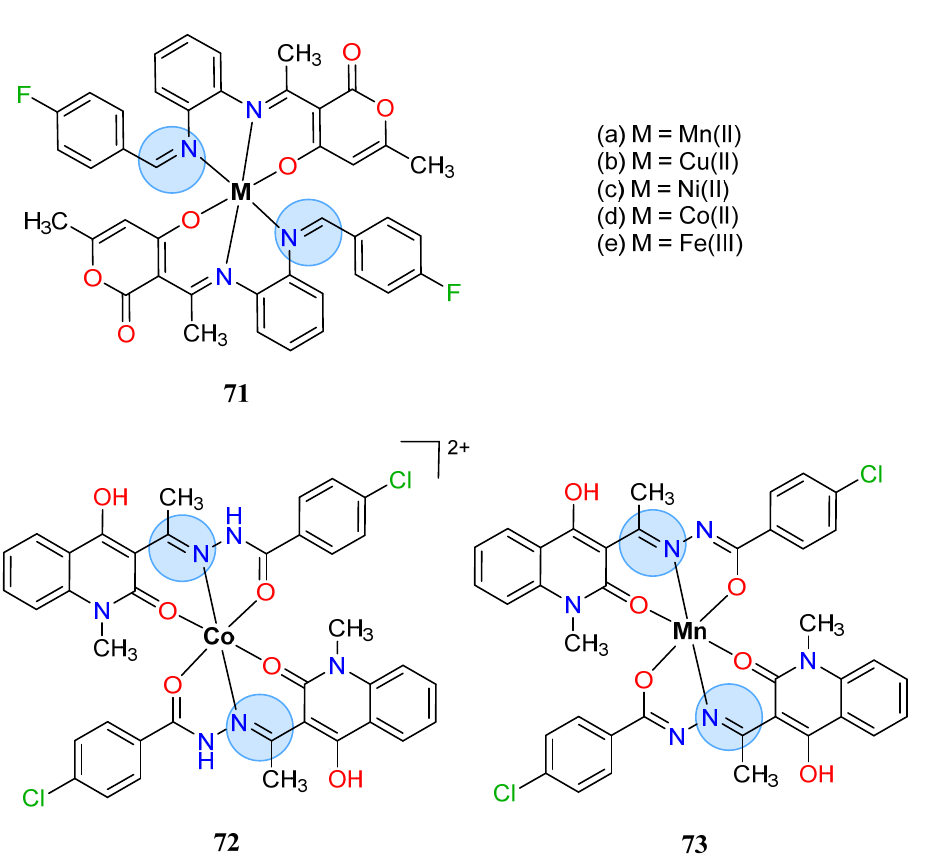
Figure 34. Metal complexes with Schiff base ligands (NNO and ONO) reported by Chondhekar group, studied for their antimicrobial activity.